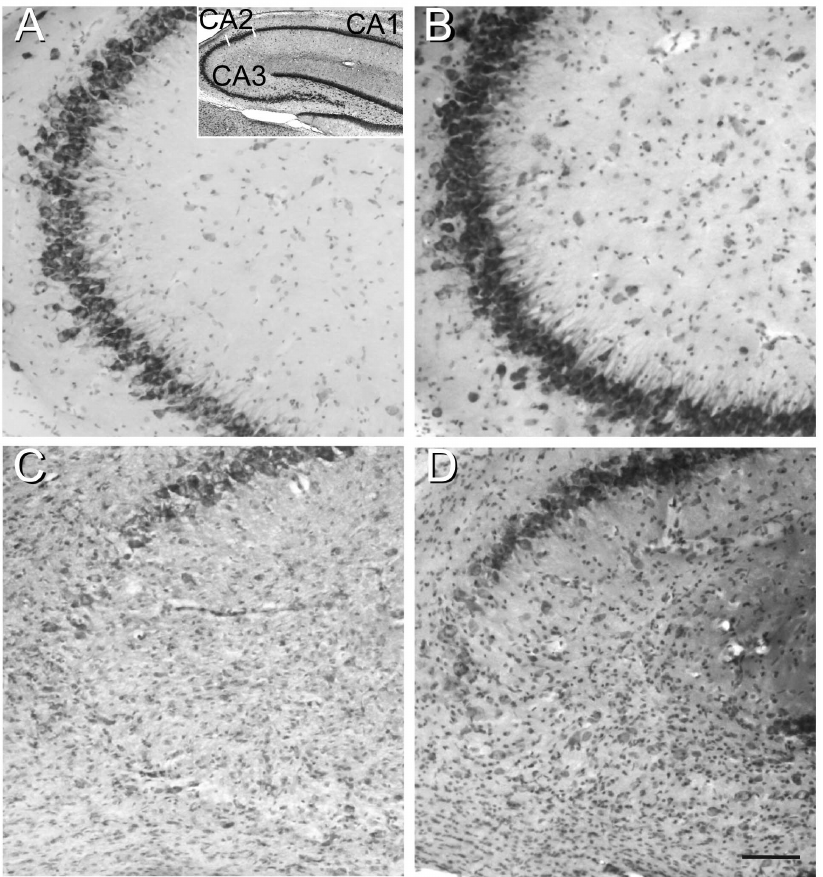
Figure 1. TMT-induced neuronal loss in the rat hippocampus. Micrographs of Nissl-stained 40 m m sagittal sections showing the CA3 subfield, as indicated in the image in the box, from dorsal hippocampus of CTRL + saline- (A), CTRL + NPY- (B), TMT + saline- (C) and TMT + NPY- (D) treated rats. Severe pyramidal neuronal loss is evident in both groups of TMT-treated animals (C, D). Scale bar: 160 m m.